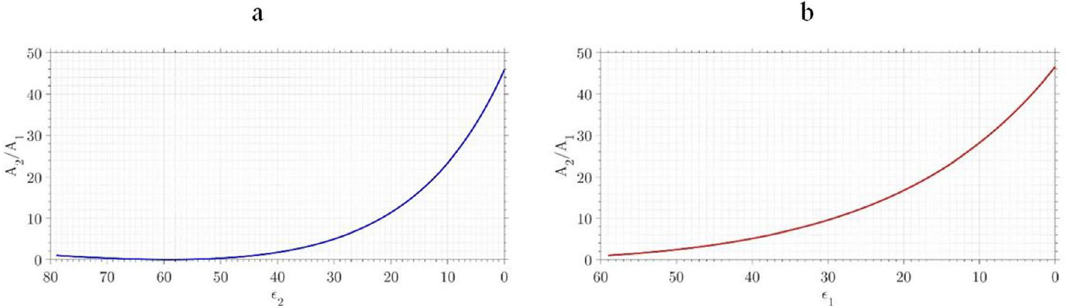
Figure 15. The ratio of A 2 / A 1 increases by reduction in ( a ) media permittivity, ( b ) cell